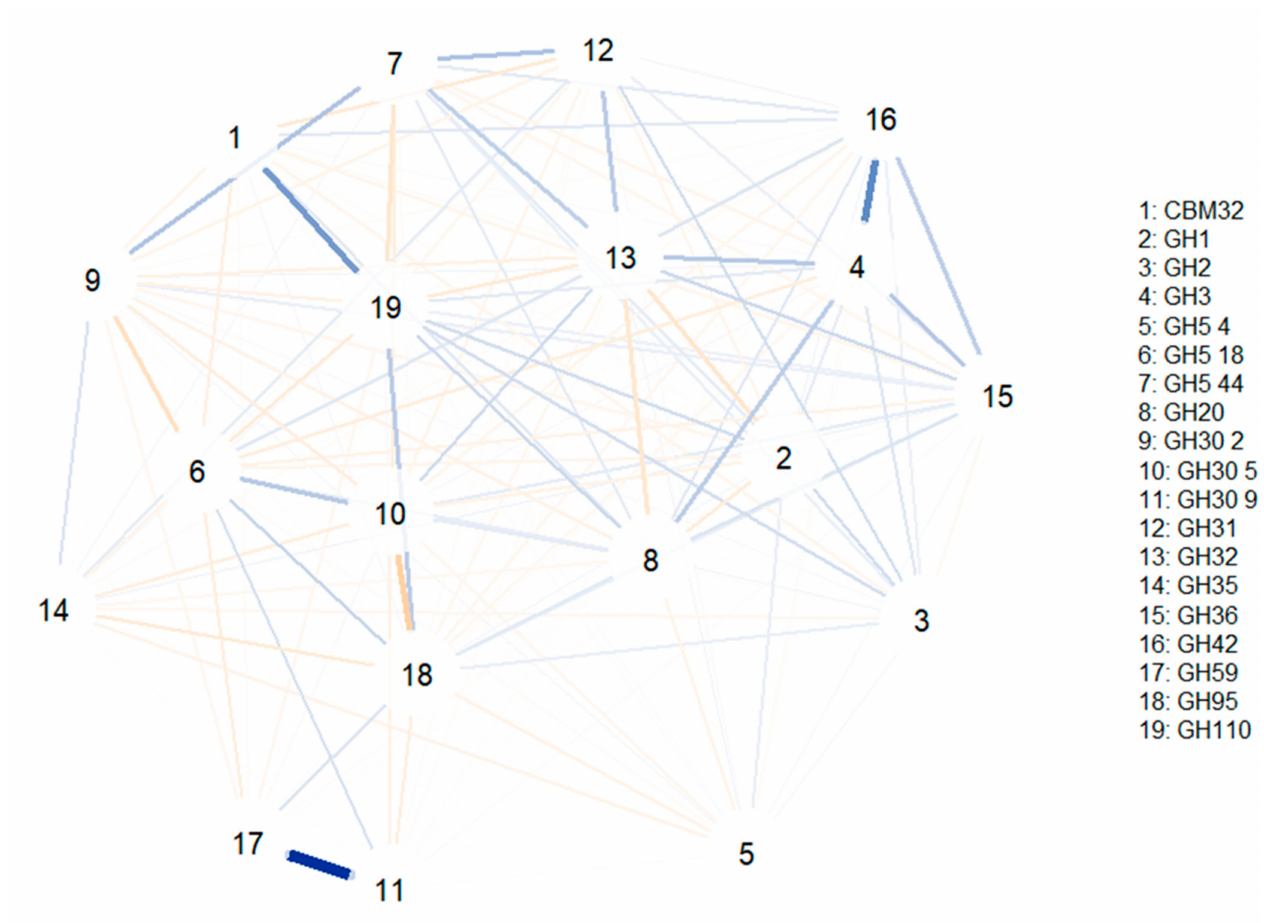
Figure 5. Correlation network illustrating positive and negative associations between glycosidase activities capable of degrading galacto- and fructo-oligosaccharides (GOS and FOS) as well as human milk oligosaccharides (HMOs), encoded in metagenome-assembled genomes (MAGs) from Bifidobacterium . Blue lines indicate positive associations, while saffron lines suggest negative associations. Line thickness is in proportion to magnitude. Specific activities included in each glycosidase family can be found in Supplementary Materials Table